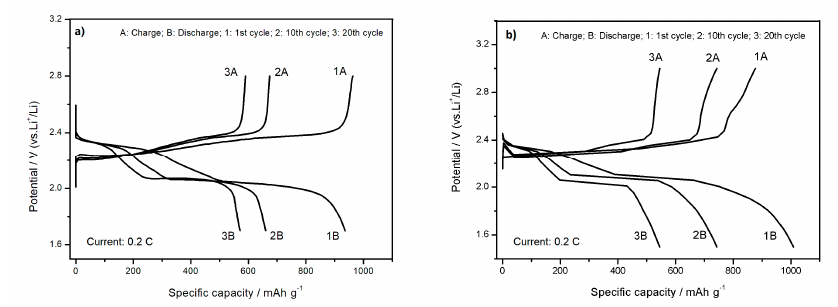
Figure 9. ( a ) The charge-discharge curves of poly(S-Sty-P) terpolymer @ CCB battery; ( b ) the charge-discharge curves of poly(S-Sty-P) terpolymer @ GF battery.